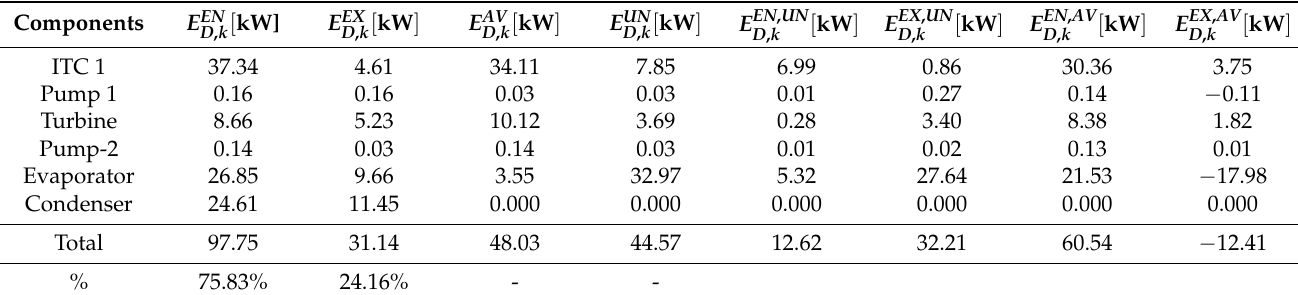
Table 11. Disaggregation of exergy destroyed for each component .